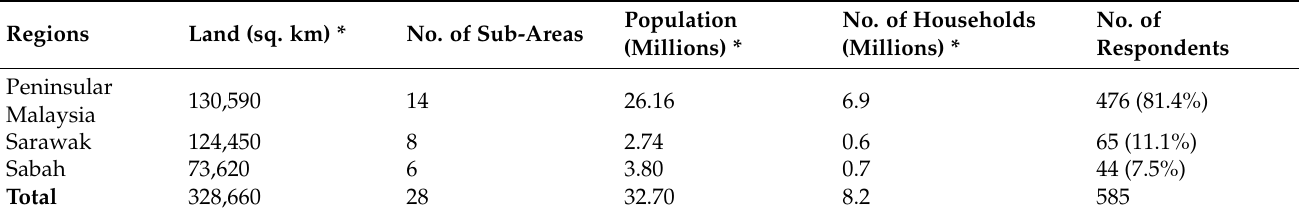
Table 1. Distribution of samples from each